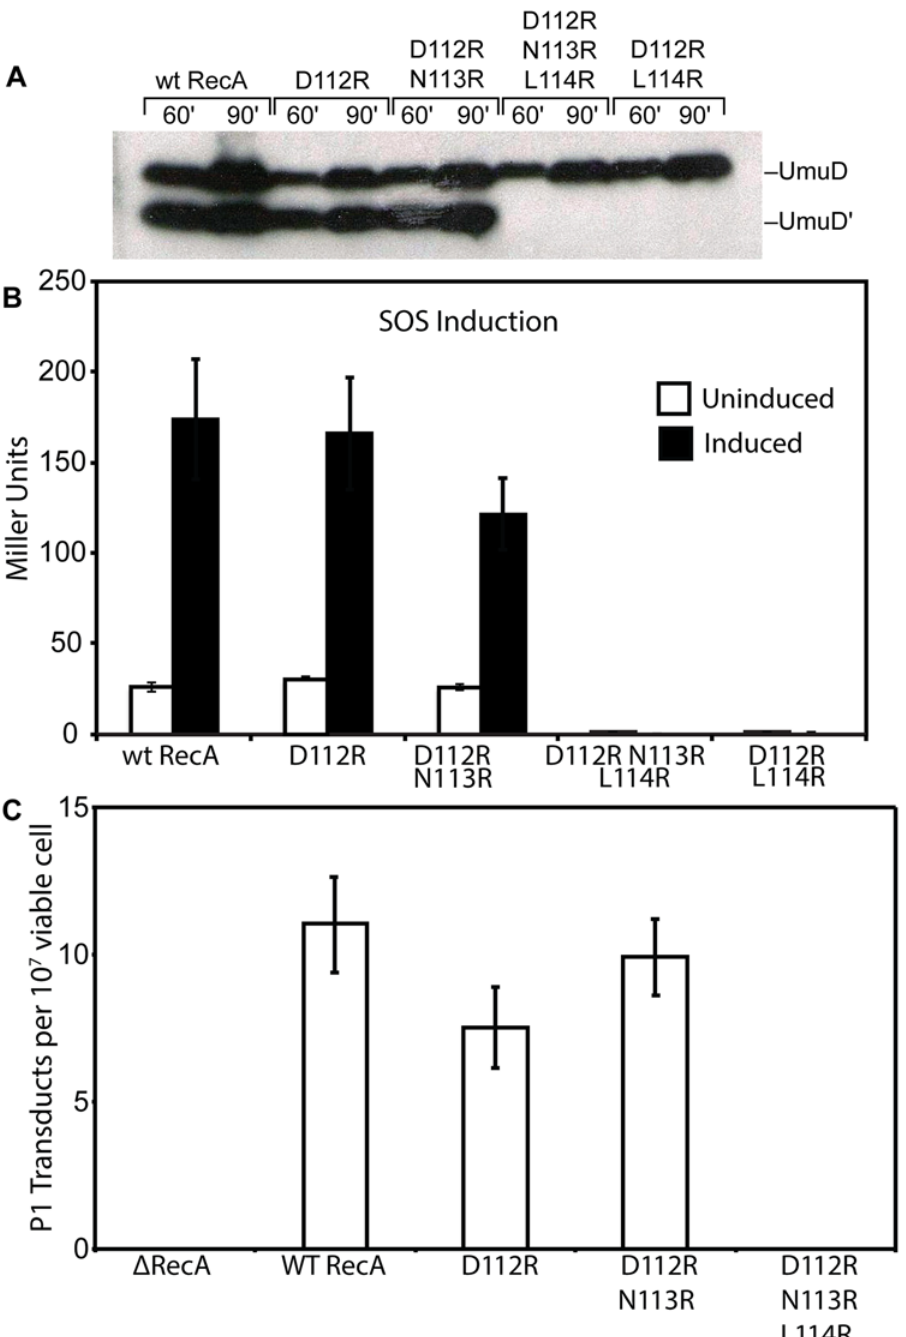
Fig 1. In vivo activities of RecA mutants. (A) Cleavage of UmuD in vivo . Western blot analysis of UmuD cleavage to UmuD' was done as described in Methods. Strains harboring recA mutants on the chromosome where transformed with pJM103 (UmuD) and pT7 pol26 (Tet R ) in order to visualize UmuD cleavage. Cells were induced for UmuD production and treated with 60 J/m 2 to induce autocatalytic cleavage by the recA mutants. An equal cell OD was loaded for each sample and visualized with anti-UmuD/D' antibodies. (B) Induction of the SOS response in vivo . β -galactosidase assays were performed in cells uninduced and induced for the SOS response after treatment with a UV dose of 30 J/m 2 . An SOS reporter plasmid was transformed into strains with the recA mutants on the chromosome as described in Methods. Miller units were calculated for each strain. (C) RecA-dependent recombination in vivo , as measured by P1